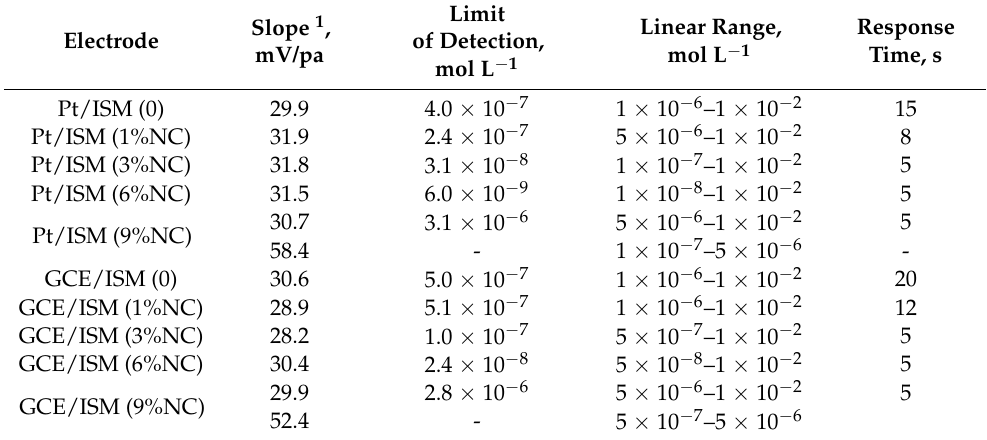
Table 2. Analytical parameters of the studied Pb(II)-ISEs.